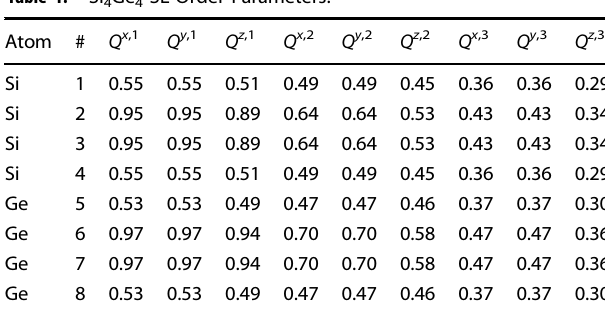
Table 1. Si 4 Ge 4 SL Order Parameters.